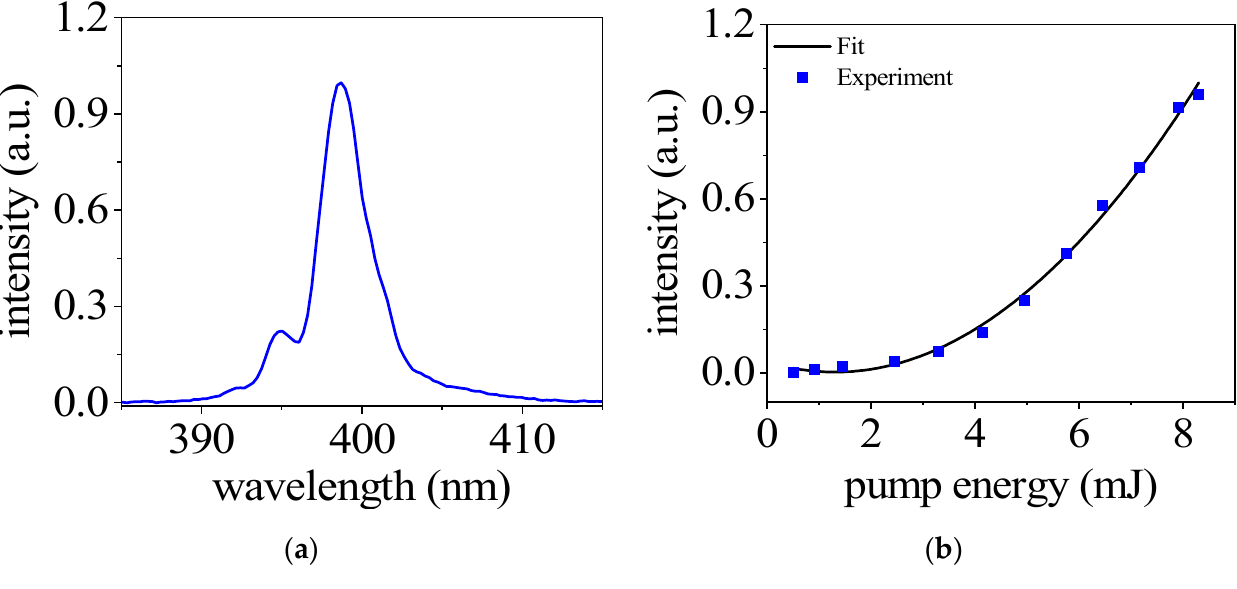
Figure 2. ( a ) Spectra of second harmonic generated in nitrogen with pump energy of 8.7 mJ. ( b ) The intensity of the SH signal as a function of the pump energy. The gas pressure is at 20 mbar in both ( a , b ).